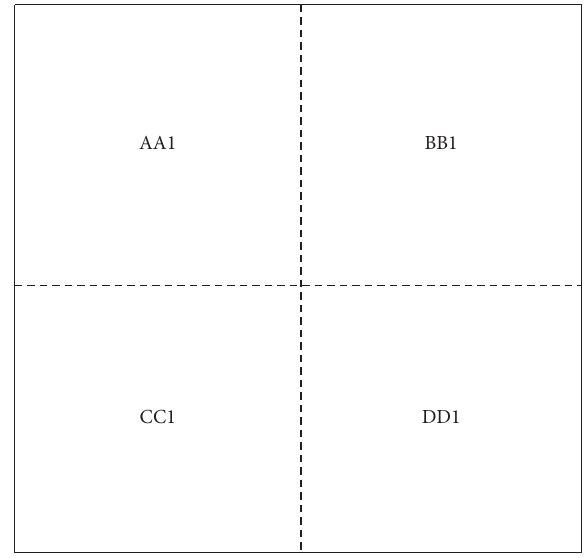
Figure 1: Video image structure decomposed by wavelet